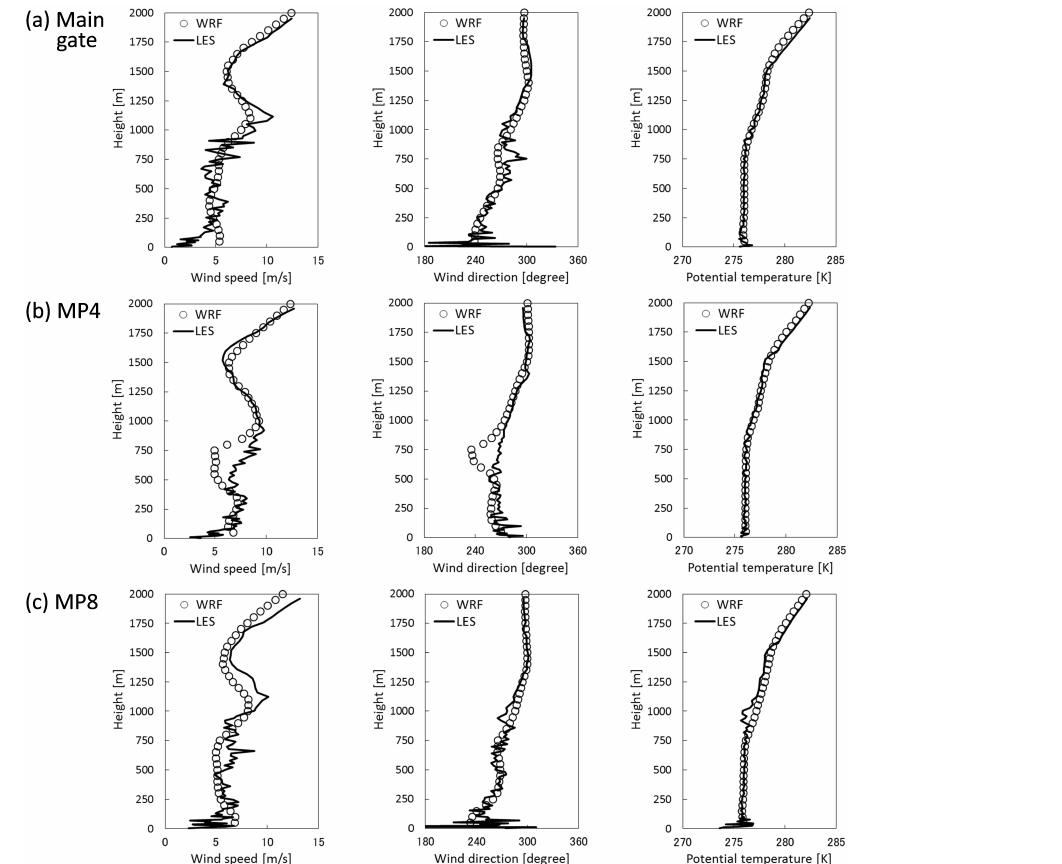
Figure 5. Vertical profiles of wind speed, wind direction, and potential temperature obtained at (a) Main gate, (b) MP4, and (c) MP8 at 06:00UTC 12 March 2011. The locations of Main gate, MP4, and MP8 are shown in Fig.